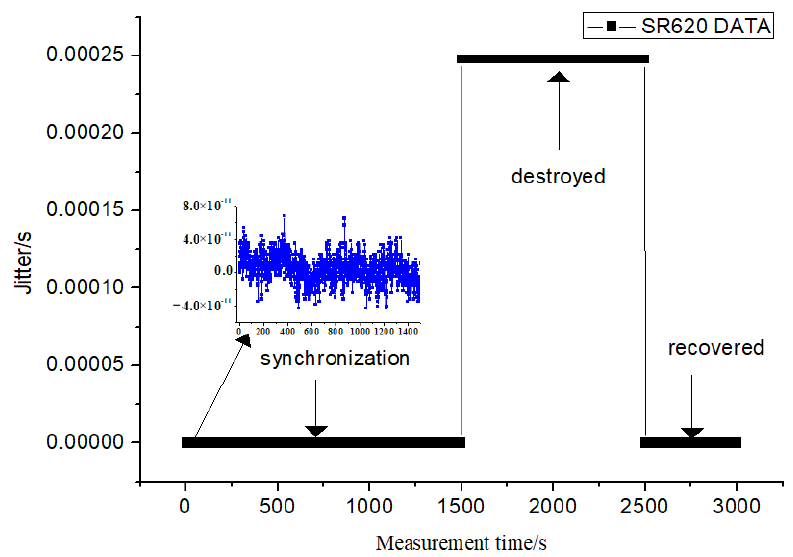
Figure 5. Comparison of system synchronization of before and after the encryption was damaged.